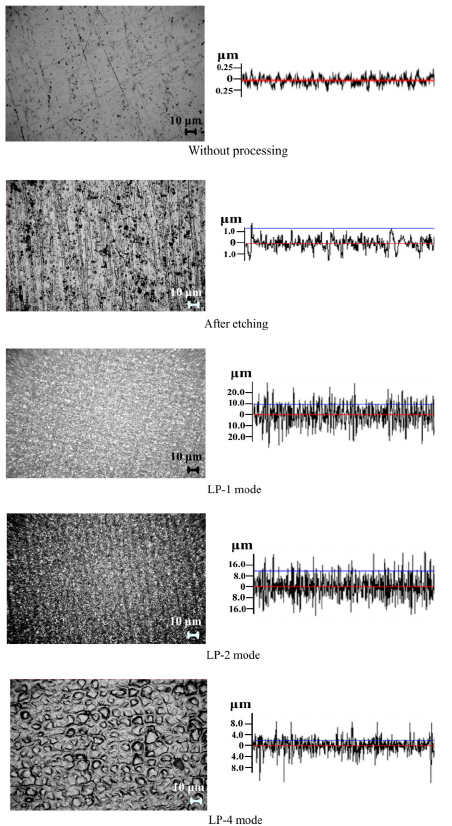
Figure 1. Micrographs (magnification ×100) and profilograms of the surface of alloy